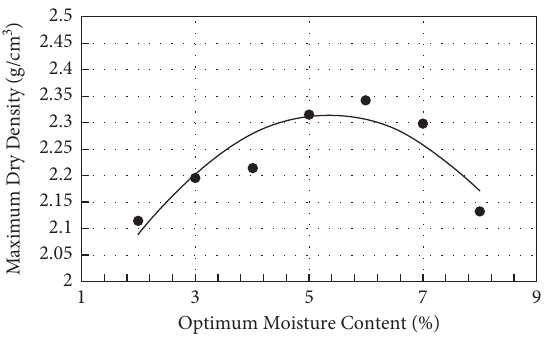
Figure 2: Sample gradation